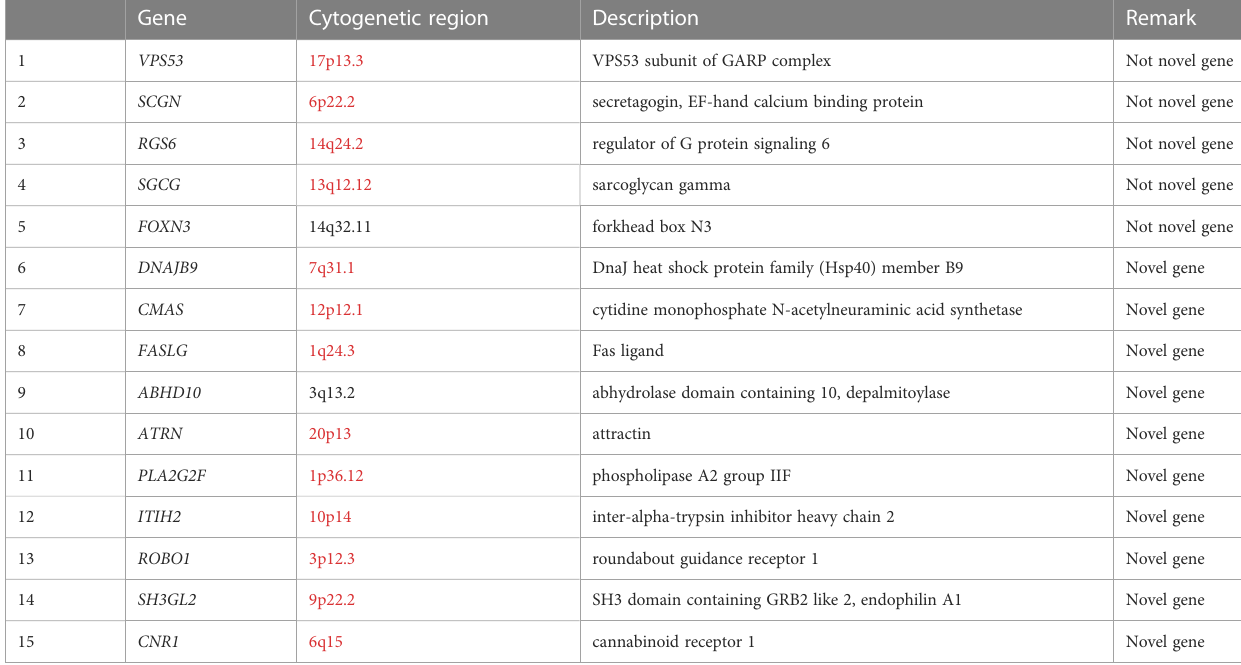
TABLE 3 Core genes after GWAS analysis and differential gene expression analysis